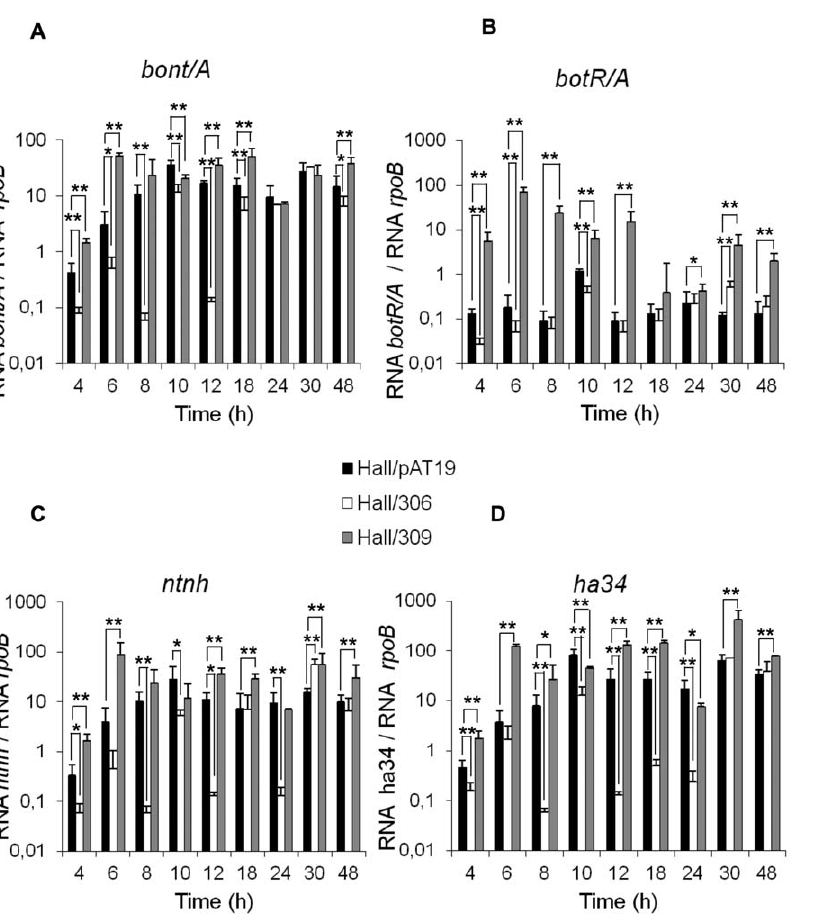
Figure 2. Kinetics of transcript levels of bont/A,botR/A,ntnh , and ha34 genes in Hall botR/A isogenic antisense strains. Transcript levels were quantified by qRT-PCR at 4, 6, 8, 10, 12, 18, 24, 30 and 48 h of culture and normalized versus housekeeping rpoB gene in Hall/pAT19 (empty vector), Hall/306 (antisense botR/A mRNA), and Hall/309 ( botR/A overexpression). Data are mean values + / 2 SD from 9 independent experiments, *P , 0.05 and **P ,